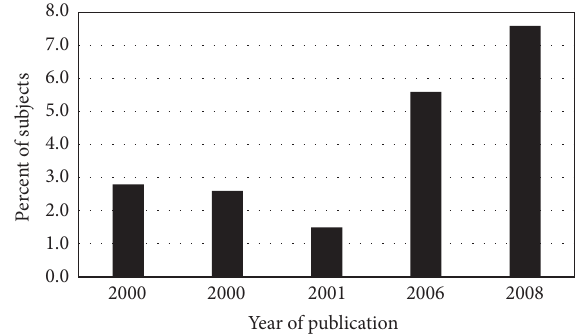
Figure 4: Cirrhosis in screening hemochromatosis. Percentages of participants in population-based studies [3, 172, 179, 180] and in an archived liver biopsy collection (second 2000 publication) [181] discovered to have HFE p.C282Y homozygosity who were previously diagnosed or were subsequently demonstrated to have advanced hepatic fibrosis or cirrhosis by biopsy [3, 170, 172, 180, 181]. Greater proportions of men than women had cirrhosis. See cirrhosis prevalence in nonscreening hemochromatosis cases in Figure